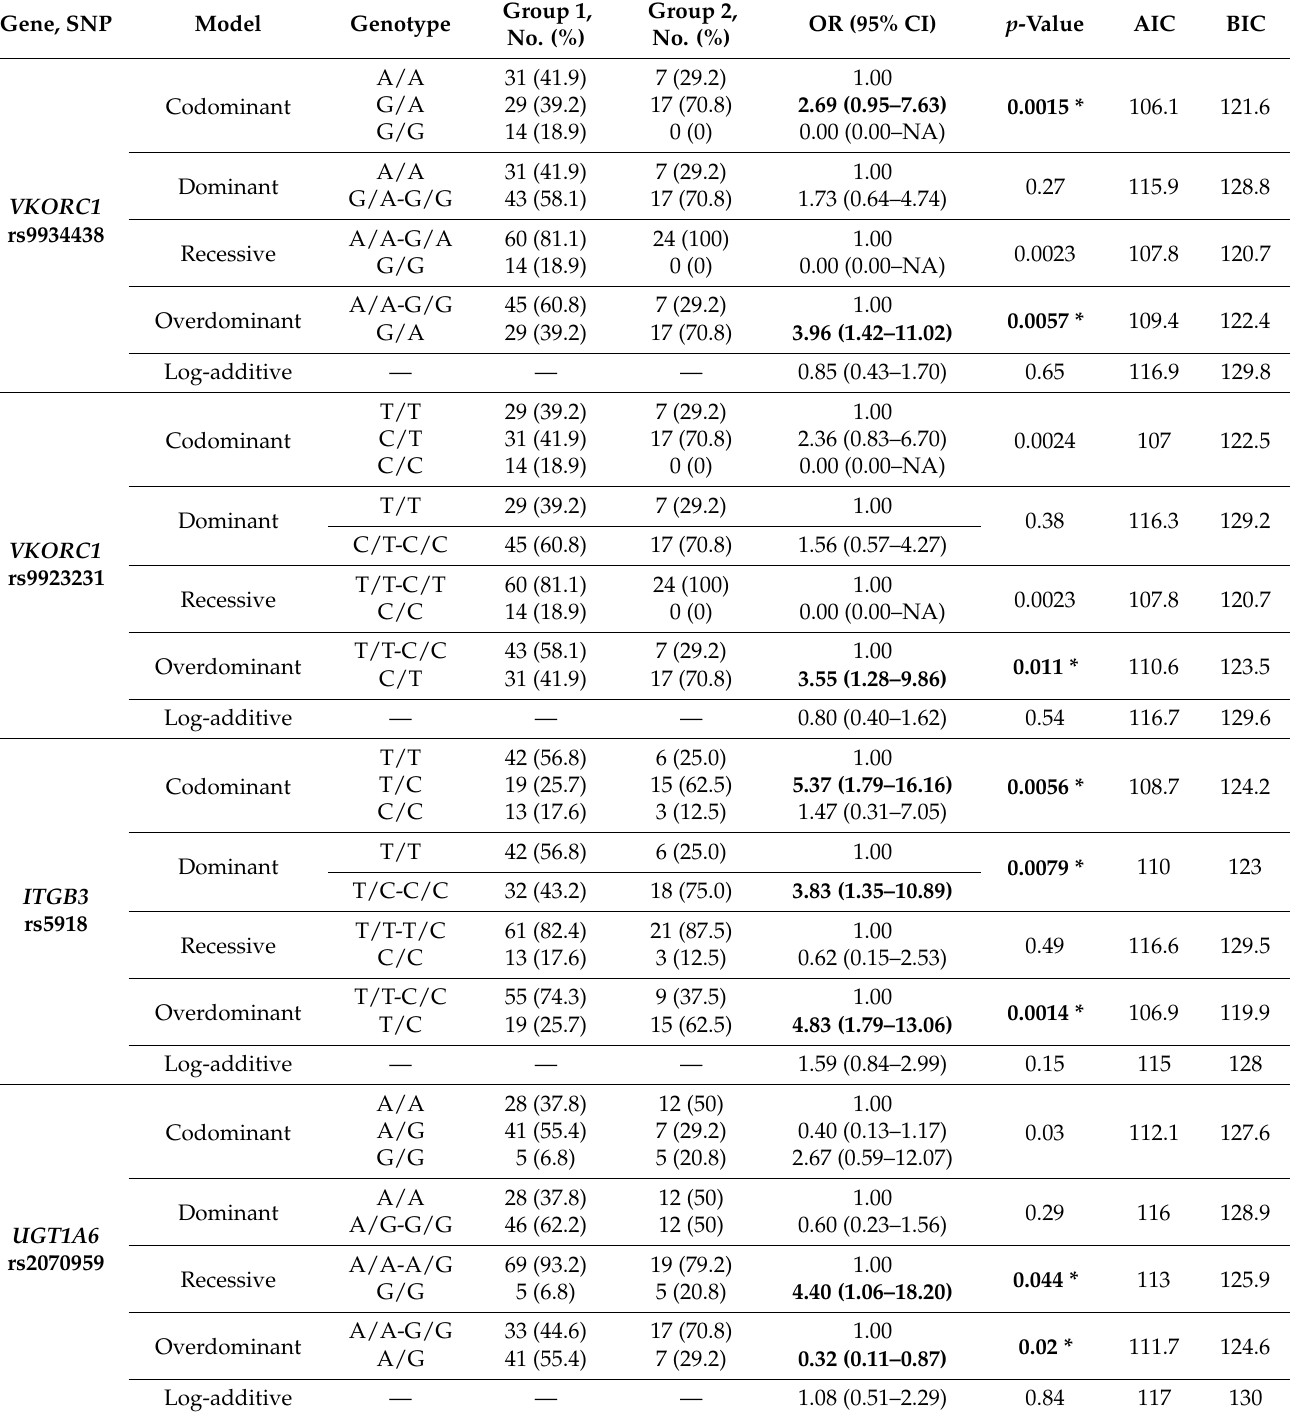
Table 6. Association analysis of SNP genotypes with complications’ development in HF groups (adjusted for age, BMI and